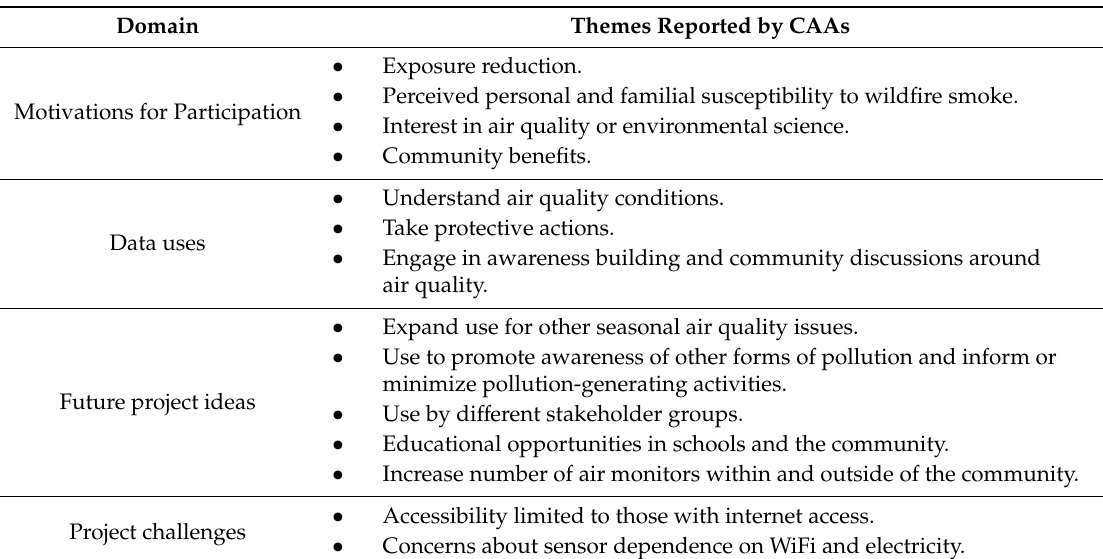
Table 2. Key themes in CAA-reported motivations for participation, data uses, future project ideas, and project